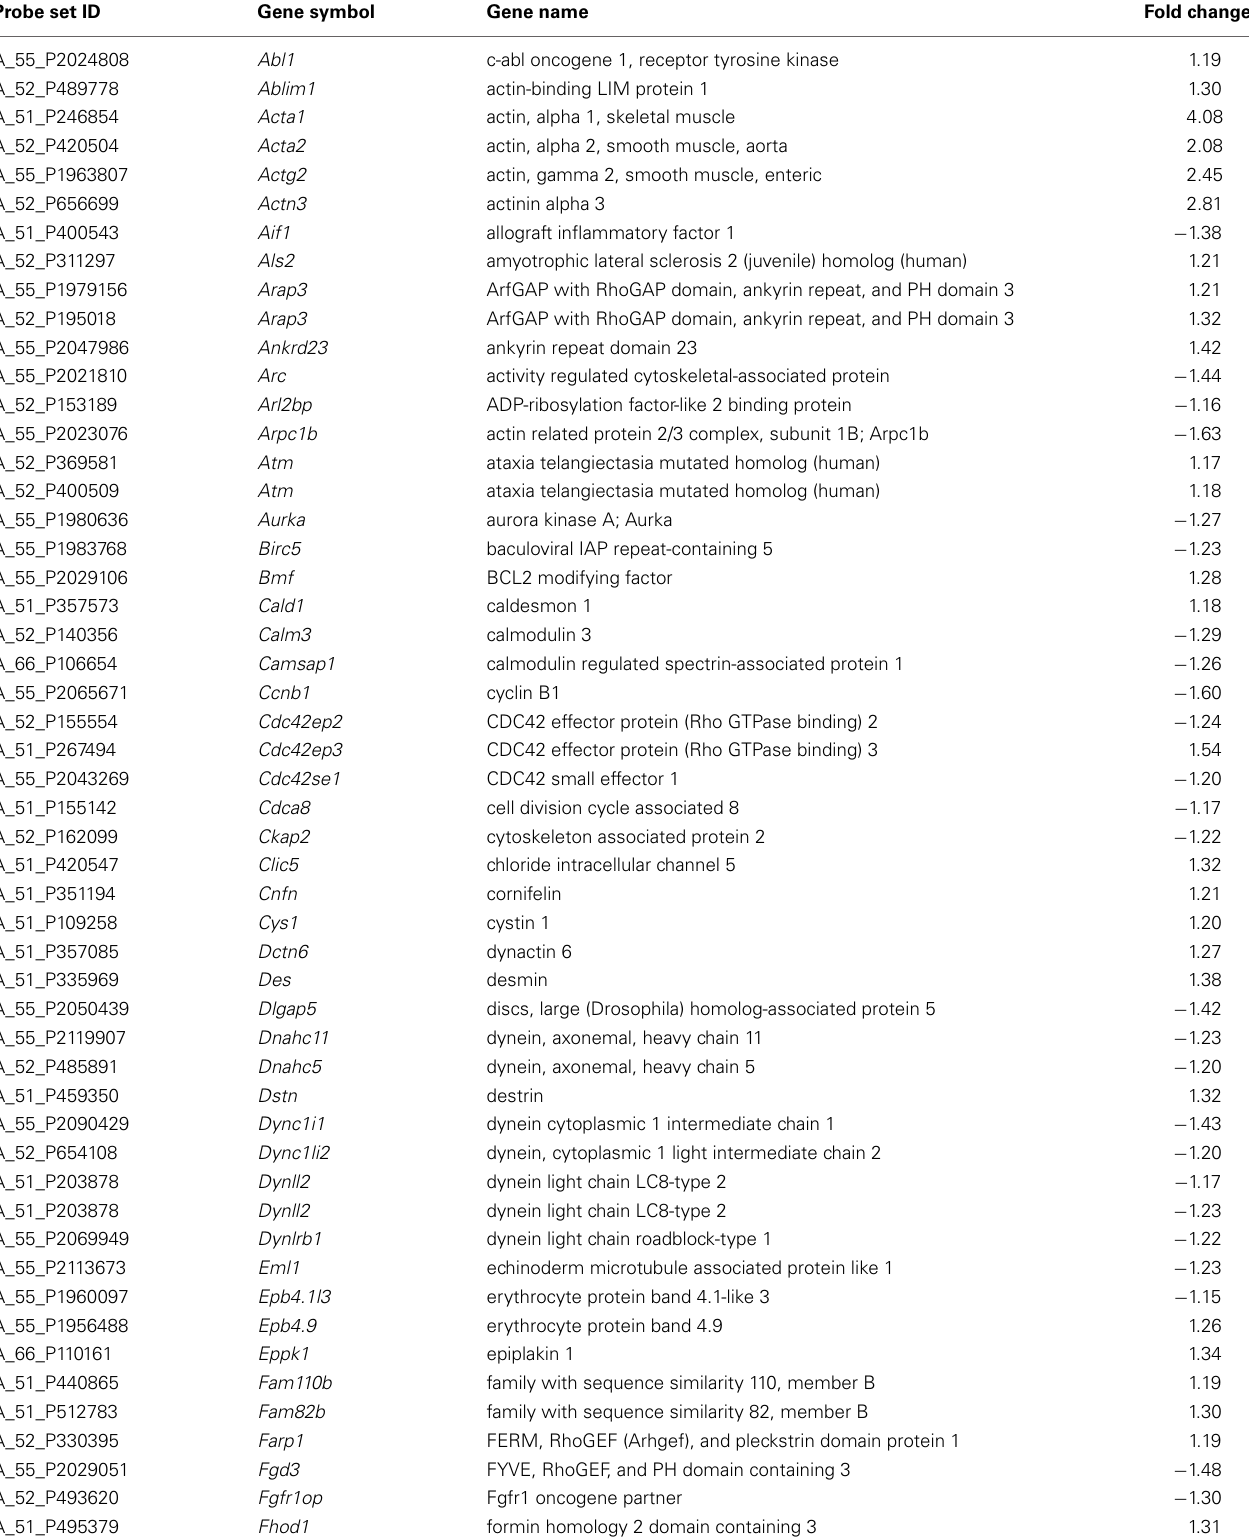
Table 3 | List of differentially expressed genes in sciatic nerve of 60 days old SOD1 G93A mice related to cytoskeleton. Probe set